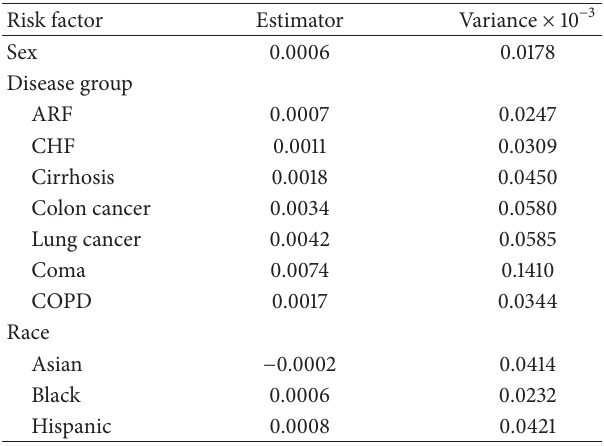
Table4:AppliedtoSUPPORTdata.Estimationresultsofsignificant binary variables using the SCAD